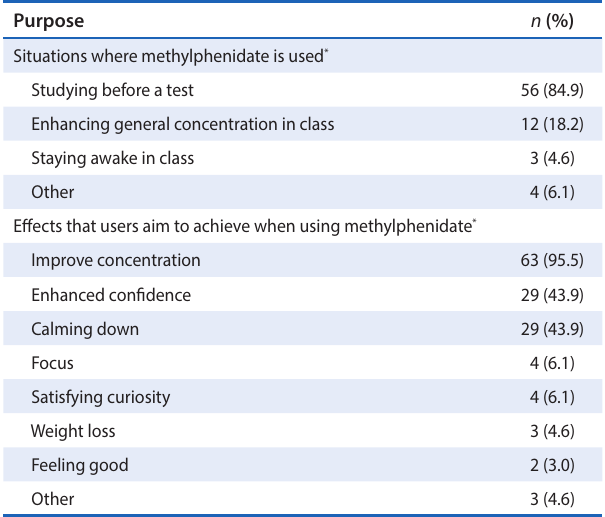
*More than one option could be selected.